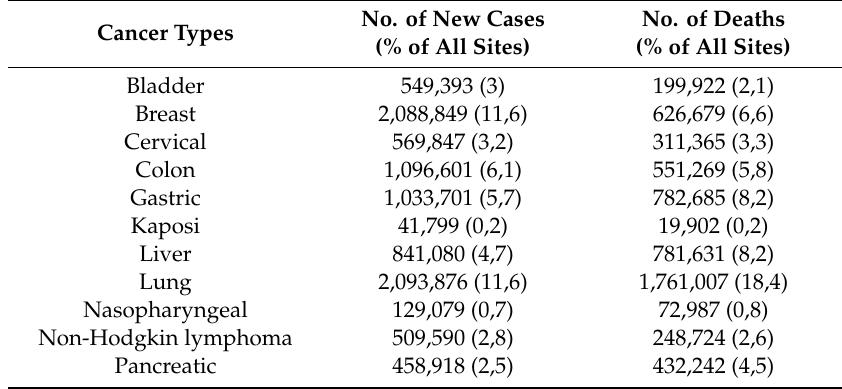
Table 1. Worldwide number of new cases and deaths for cancers with associated infectious agents identified (Cancer Facts & Figures